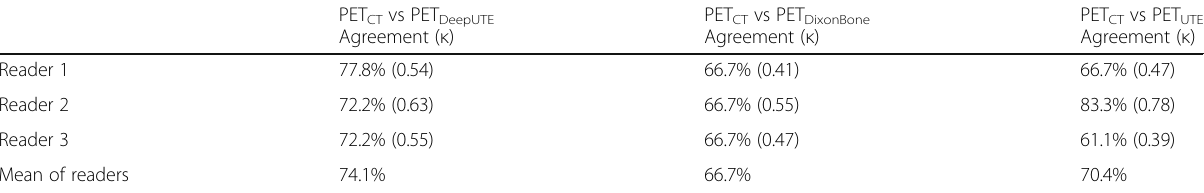
Table 5 κ -statistics for the agreement between PET CT and PET MRAC (PET DeepUTE , PET DixonBone , PET UTE ) for each reader. A κ value of 0 indicates no agreement better than chance, while 1.0 means perfect agreement